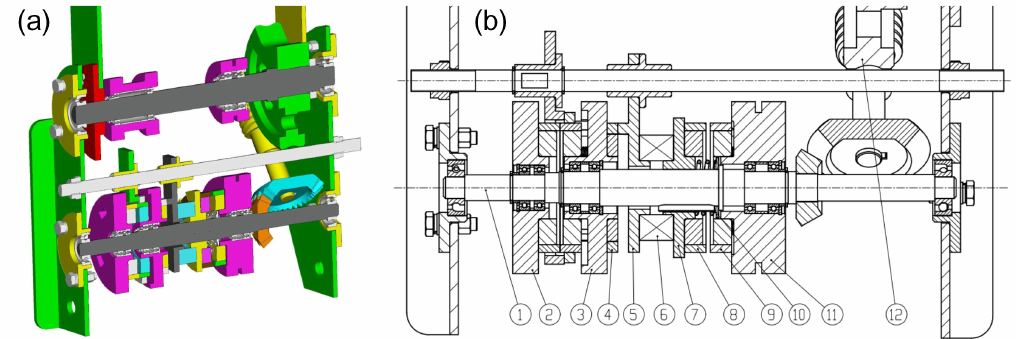
Figure 13. The illustration of the shoulder joint. ( a ) shows the 3D model section of the manipulator shoulder joint. ( b ) shows the manipulator shoulder joint in detail. The part number in this figure is used throughout the paper. 1 (cid:13) Transmission shaft for transmitting the power to the shoulder joint. 2 (cid:13) , 3 (cid:13) Switch pulleys, for switching power. 4 (cid:13) Switch cam, fixed with the switch pulley for pushing the follower side (Part 5 (cid:13) ). 5 (cid:13) Cam follower. 6 (cid:13) Thrust bearing, which is fixed with the follower and slider. 7 (cid:13) Slider, moving along the axial direction and rotating with the shaft (Part 1 (cid:13) ) synchronously. 8 (cid:13) Master clutch, fixed with the slider (Part 7 (cid:13) ). 9 (cid:13) Slave clutch, fixed with the drive pulley. 10 (cid:13) Guide key. 11 (cid:13) Drive pulley, driven by the drive motor. 12 (cid:13) Worm and worm